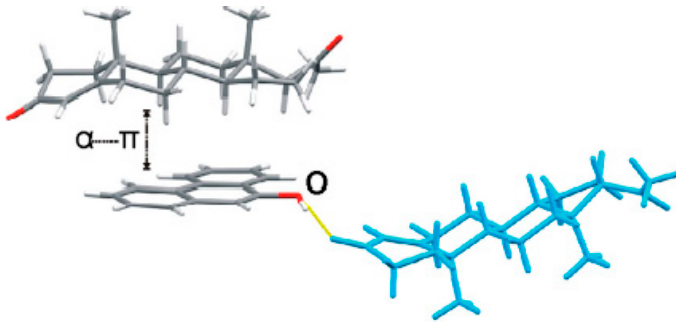
Figure 1. Crystal structure of a progesterone · 9-phenanthrol complex displaying an α ··· π dimer and a hydrogen-bonded neighboring progesterone (PROG) molecule (blue).